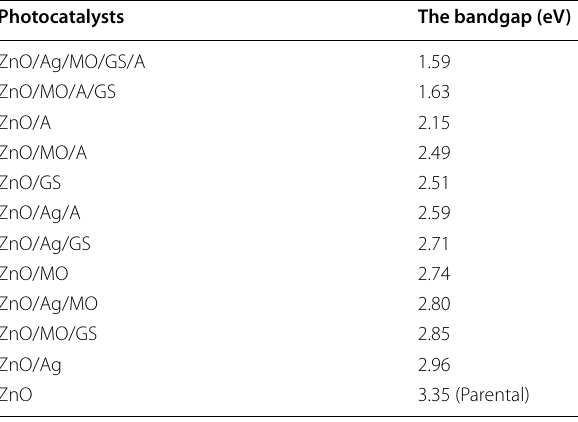
Table 1 The band gaps were obtained for various combinations in the production of a suitable photocatalyst